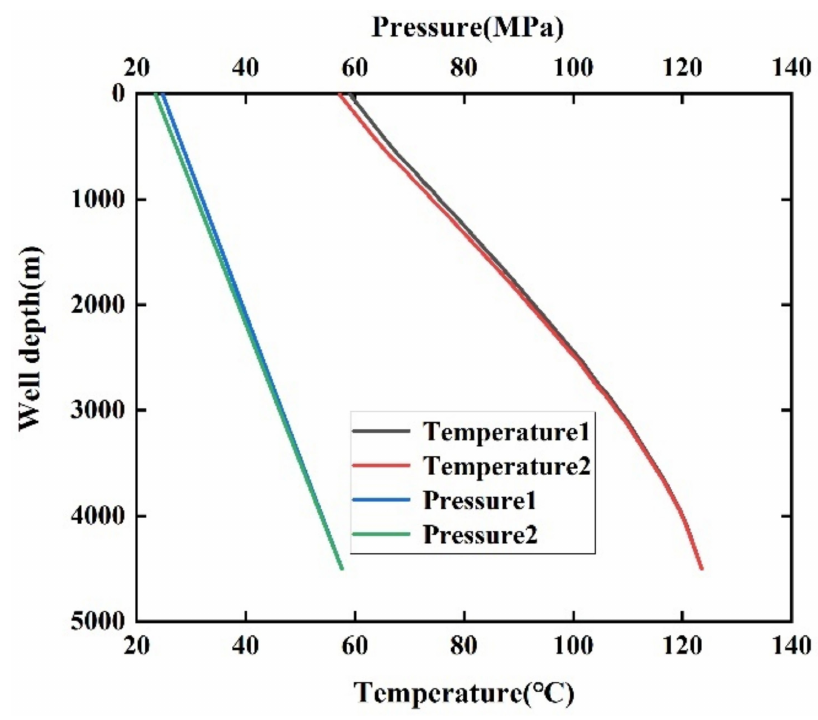
Figure 7. Model verification